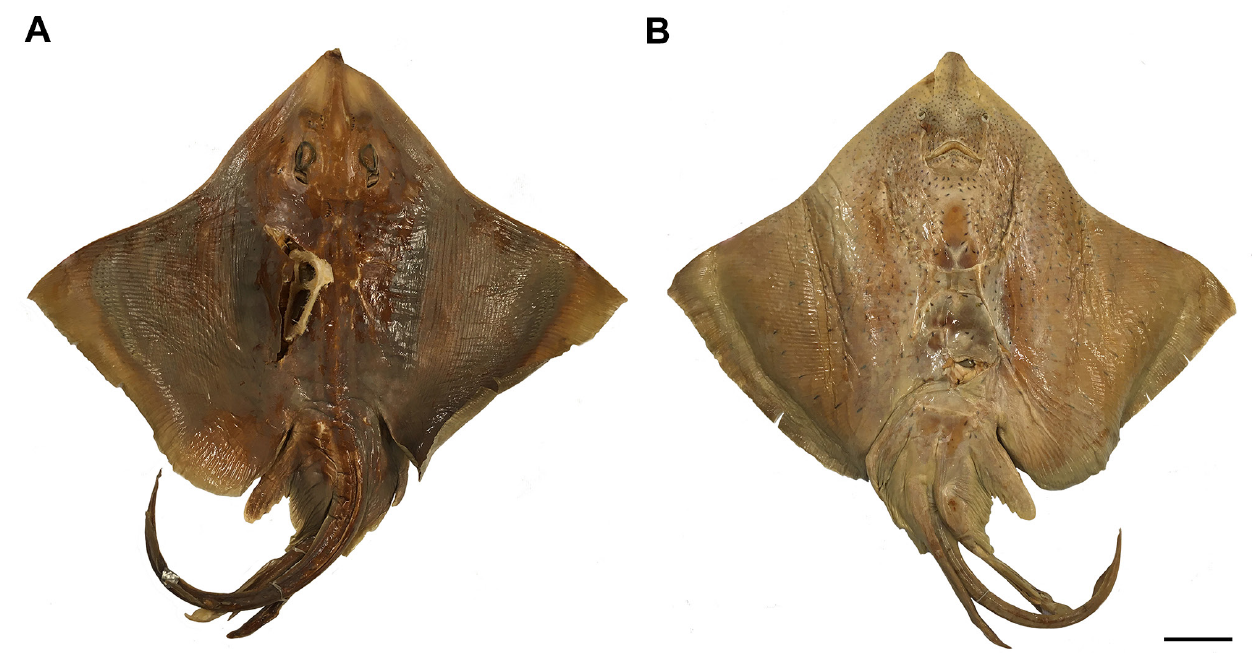
FIGURE 10 | Holotype of Atlantoraja platana , BMNH 1879.5.14.411, 647 mm TL. A. Dorsal view. B. Ventral view. Scale bar = 20